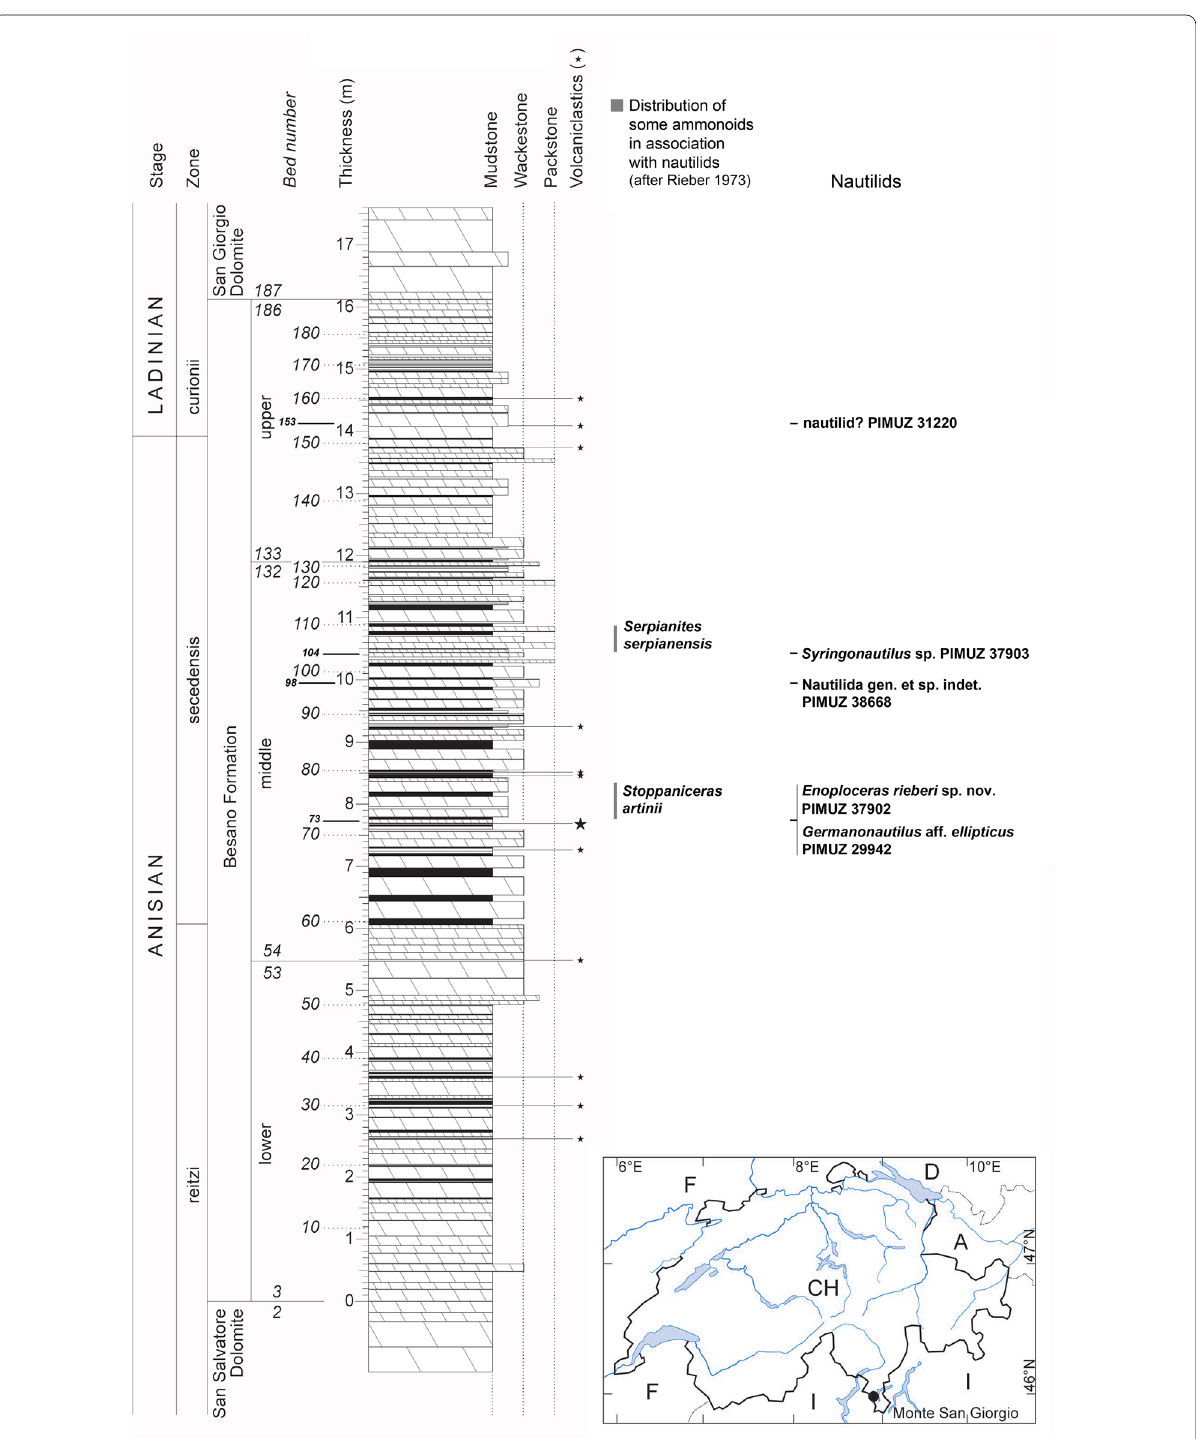
Fig. 1 Stratigraphic section of the Besano Formation at Point 902/ Mirigioli (modified after Röhl et al., 2001, Fig. 4). The stratigraphic positions of five described specimens are indicated beside this section and the distribution of some ammonoids (after Rieber, 1973a, 1973b) from the same levels (indicated in